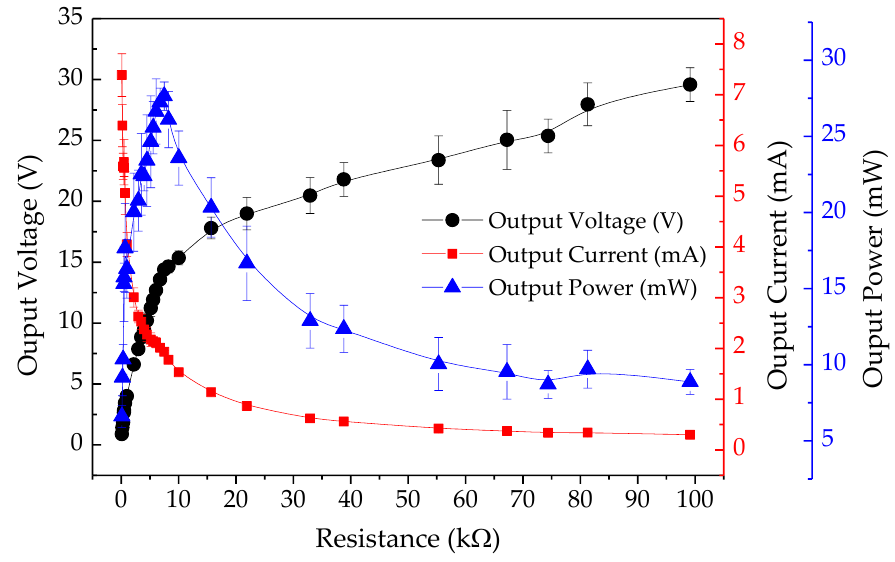
Figure 5. Electrical output characteristics of PEH across resistive loads, at 4 mm gap width.